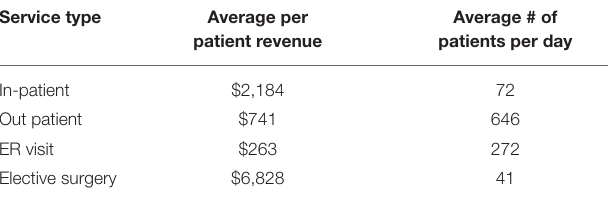
Table 1b | Average daily patient visits and